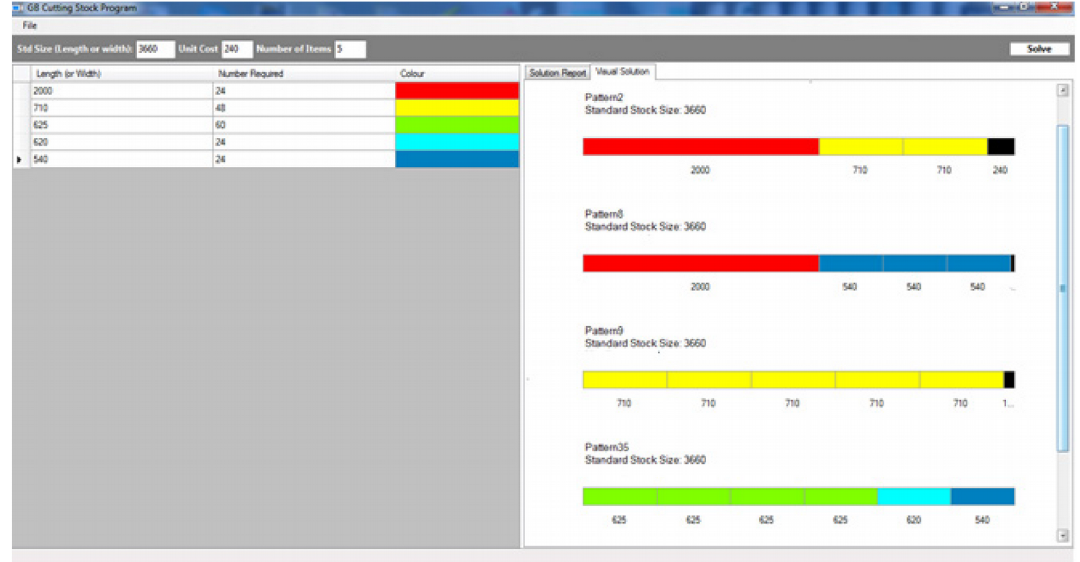
Figure 4. Optimal Cutting Plans for the flush door